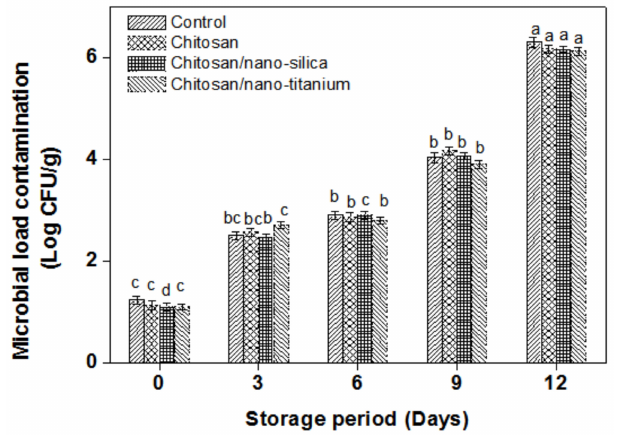
Figure 5. Effects of nano-films on microbial load contamination for white button mushrooms during storage at 4 ◦ C for 12 days; Data are mean ± SD, n = 3; ( a – d ) mean significant differences between treatments at p ≤